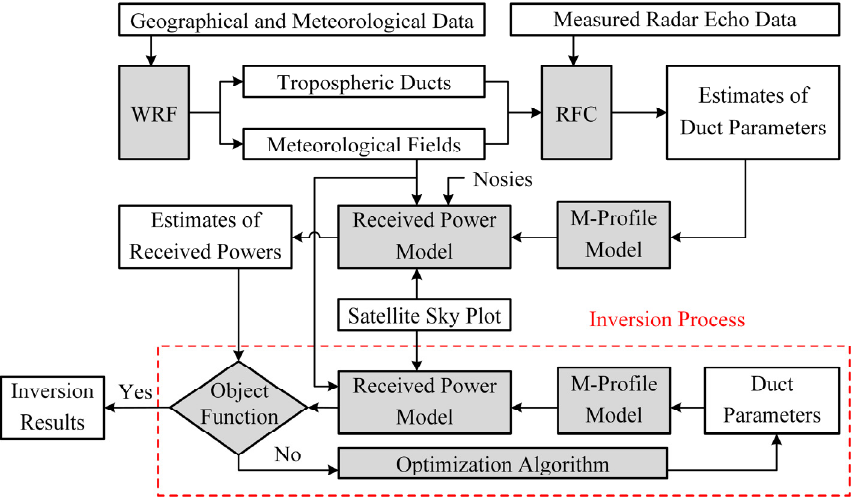
Figure 15. The principal diagram of the entire algorithm.